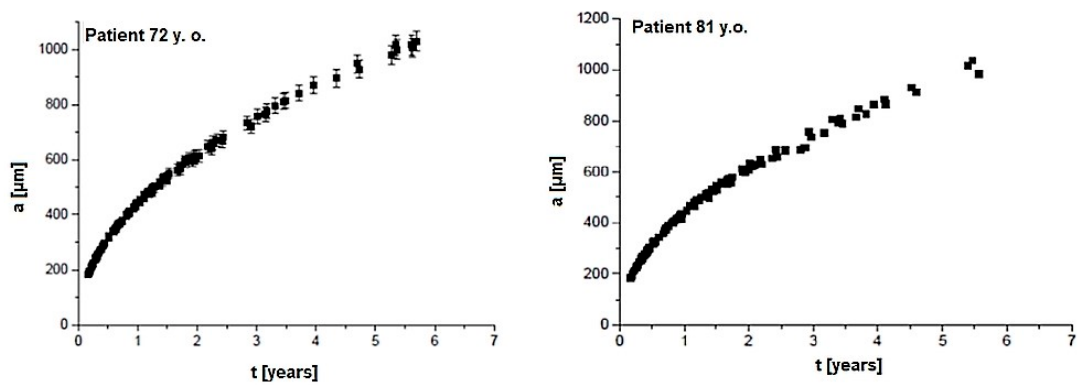
Figure 5. The dependence of the radius value of mineral grains built from calcium pyrophosphate dehydrate (CPPD) from the growth time for two cases of yellow ligaments.